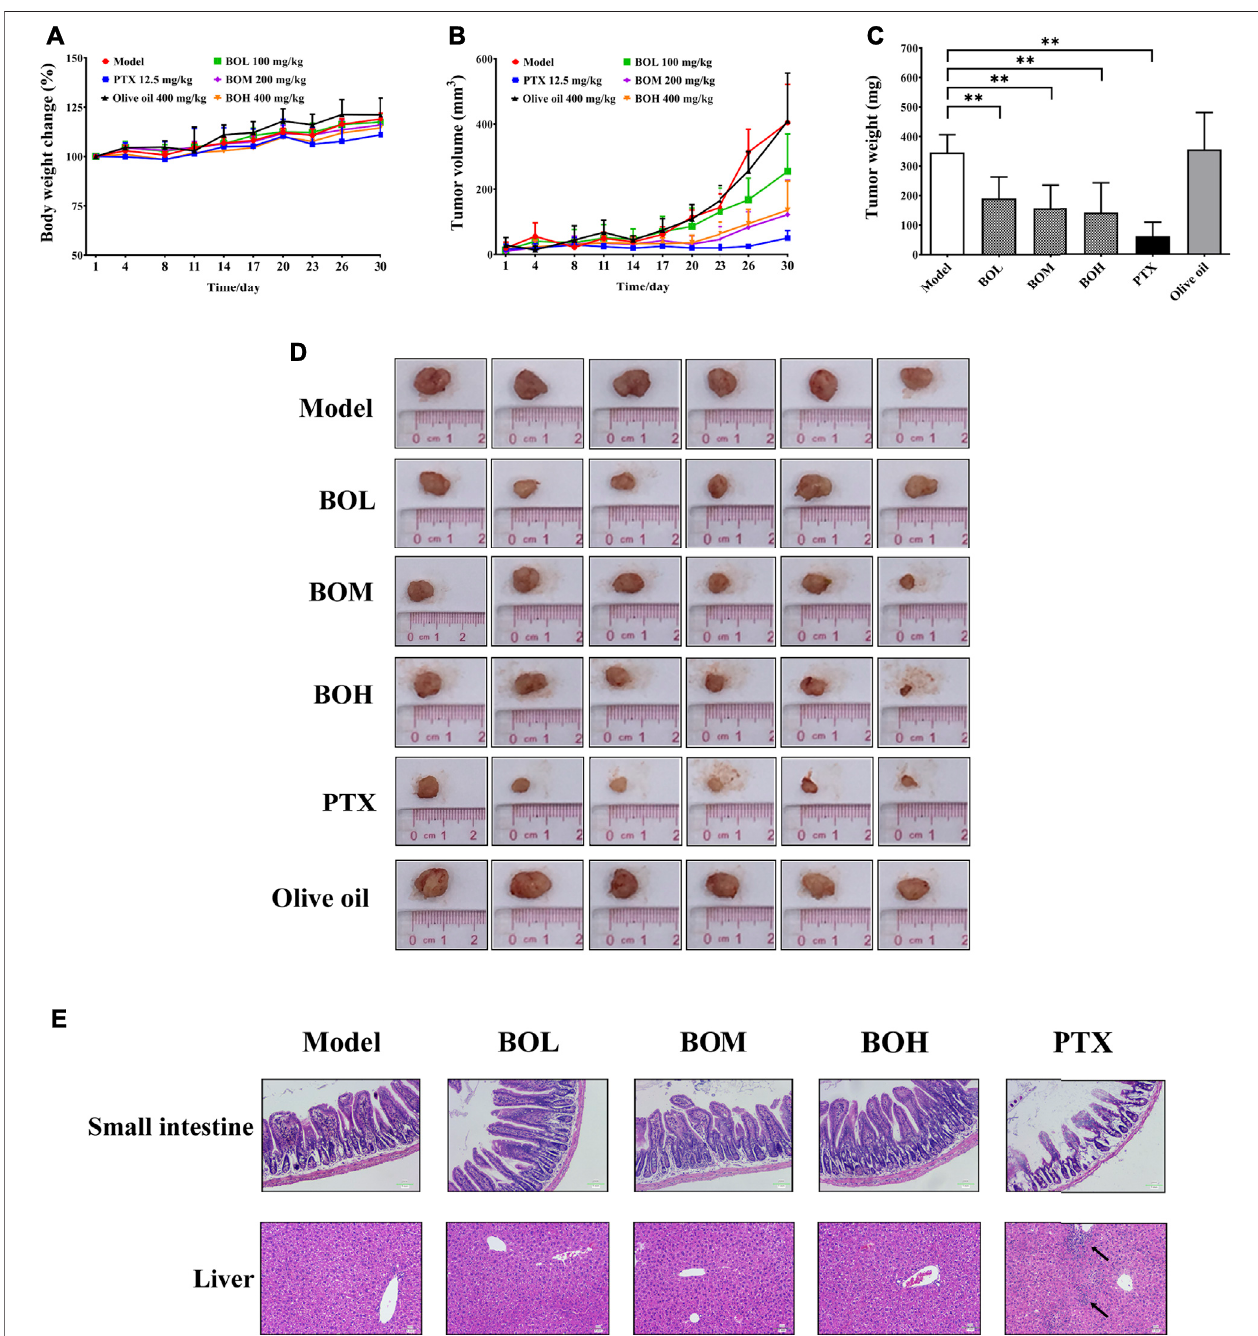
FIGURE 3 | BO suppresses MDA-MB-231 tumor growth in vivo (A – D) but has no toxicity on the small intestine and liver (E). (A) Body weight change. (B) Tumor volume. (C) Tumor weight. (D) Tumor pictures. (E) Representative pictures of H&E staining at 200 × magni fi cation, and the black arrows indicated the in fl ammatory in fi ltration. n (cid:2) 6. * p < 0.05 and ** p < 0.01.